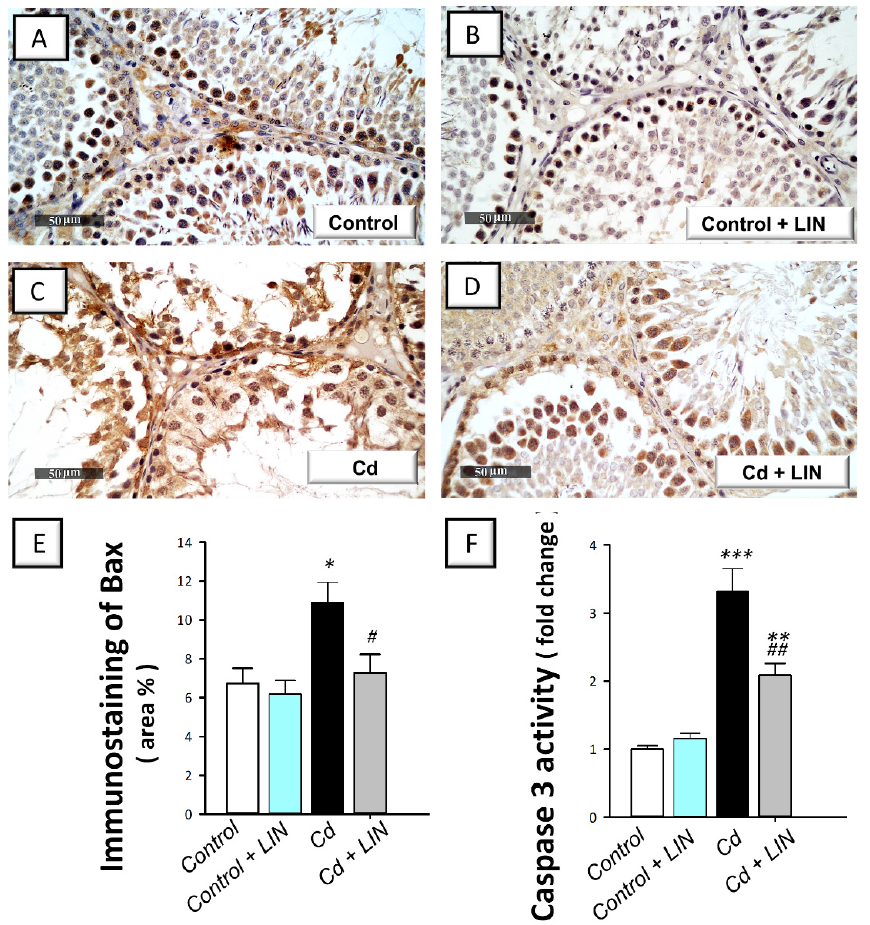
Figure 7. Effect of cadmium and/or linagliptin administration on testicular apoptosis in rats. The co ‐ treatment with linagliptin curbed testicular pro ‐ apoptotic events that were turned on by cadmium metal. This was demonstrated by downregulated protein expression of Bcl ‐ 2 associated x protein (Bax) as detected by immunohistochemistry that shows up as a brown color at 400× magnification. ( A , B ) The immunostaining of testicular Bax protein demonstrates minimal expression in the control and control + LIN groups. ( C ) The immunostaining of the pro ‐ apoptotic Bax was upregulated in the cadmium ‐ intoxicated group. ( D ) The immunostaining of Bax was downregulated in the Cd + LIN group. ( E ) Quantitative analysis of Bax immunostaining in the testicular tissue presented as the area % of the immunoreactivity/full microscopic field area. Six non ‐ overlapping fields were inspected for each specimen. In addition, co ‐ treatment with linagliptin diminished the activity of testicular executioner caspase 3 ( F ). * p < 0.05, ** p < 0.01, and *** p < 0.001 show statistical significance compared to the group of control rats; # p < 0.05, and ## p < 0.01 show statistical significance compared to the group of cadmium ‐ intoxicated rats. Values are stated as the mean ± standard error of the mean for n = 6 per group. LIN, linagliptin; Cd, cadmium chloride.